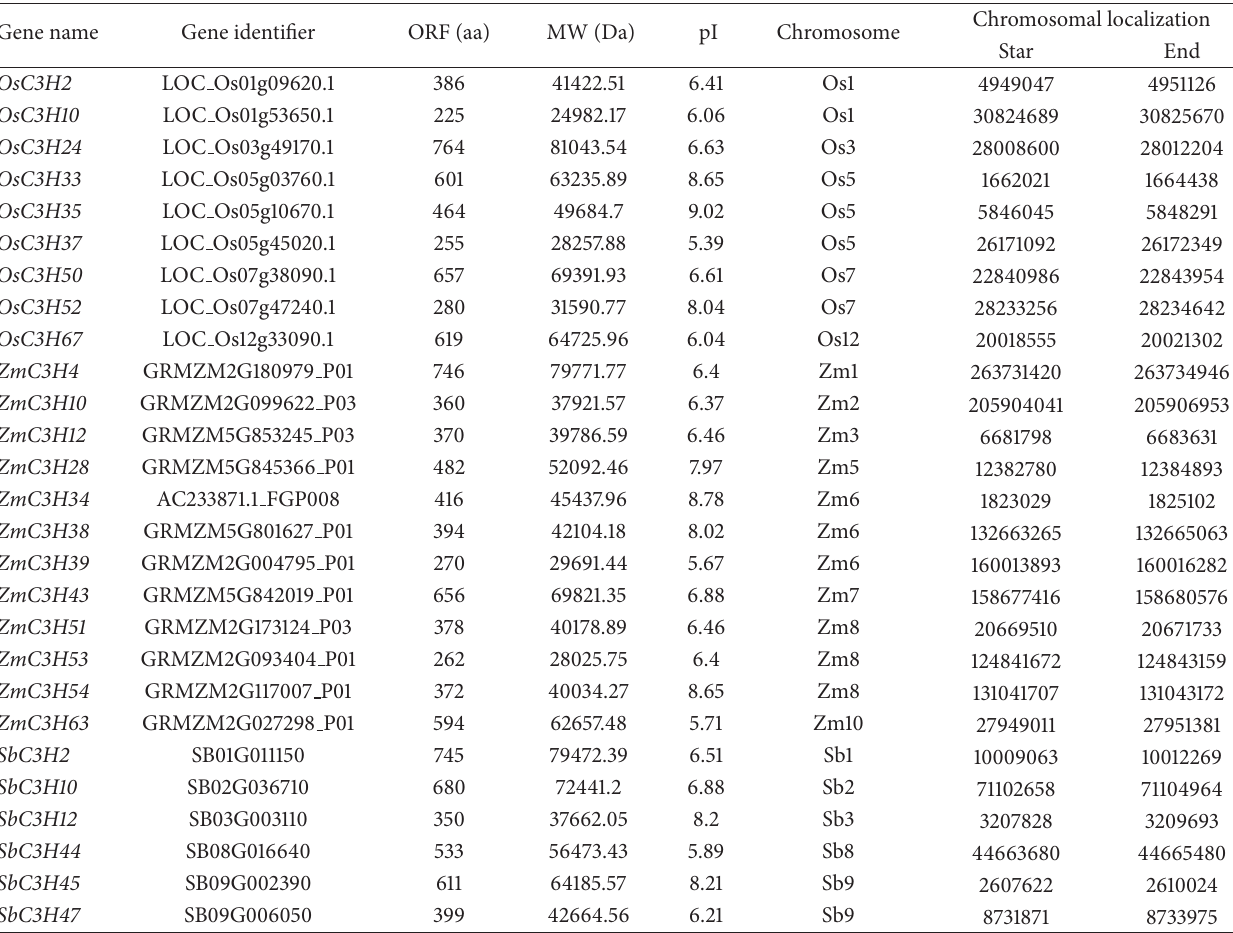
Table 1: The 27 CCCH IX genes identified in three species and their sequence characteristics (gene ID, ORF, MW, PI, and chromosome